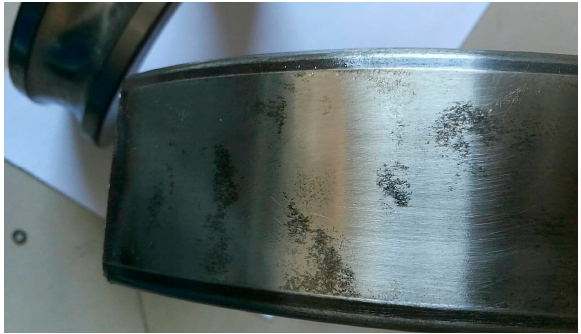
Figure 17. Scuffing on the outer race of a generator bearing due to looseness.